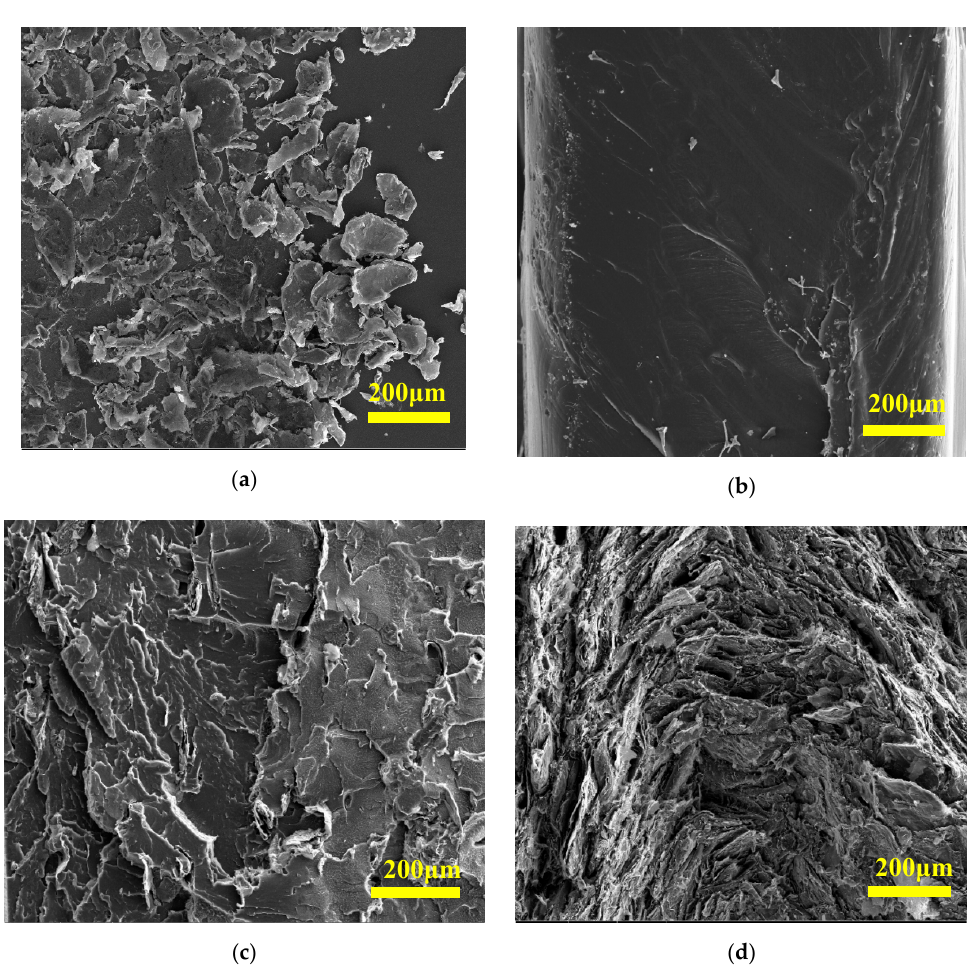
Figure 1. SEM images of ( a ) EG filler, ( b ) neat HDPE, ( c ) HDPE-10 wt.% of EG and ( d ) HDPE- 50 wt.% of EG.